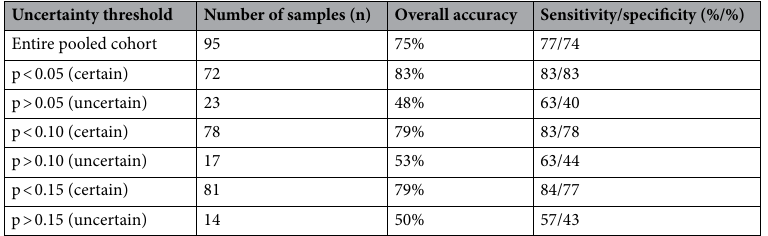
Table 2. Differences in predictive accuracy related to certain versus uncertain sample predictions in the training set (95 biopsy samples, 25 patients). Shown are the differences in predictive performance of the transductive learning GP model for the entire pooled training cohort and also when stratifying the sample predictions with high certainty (low p values) versus low certainty (high p values) at various p value thresholds.